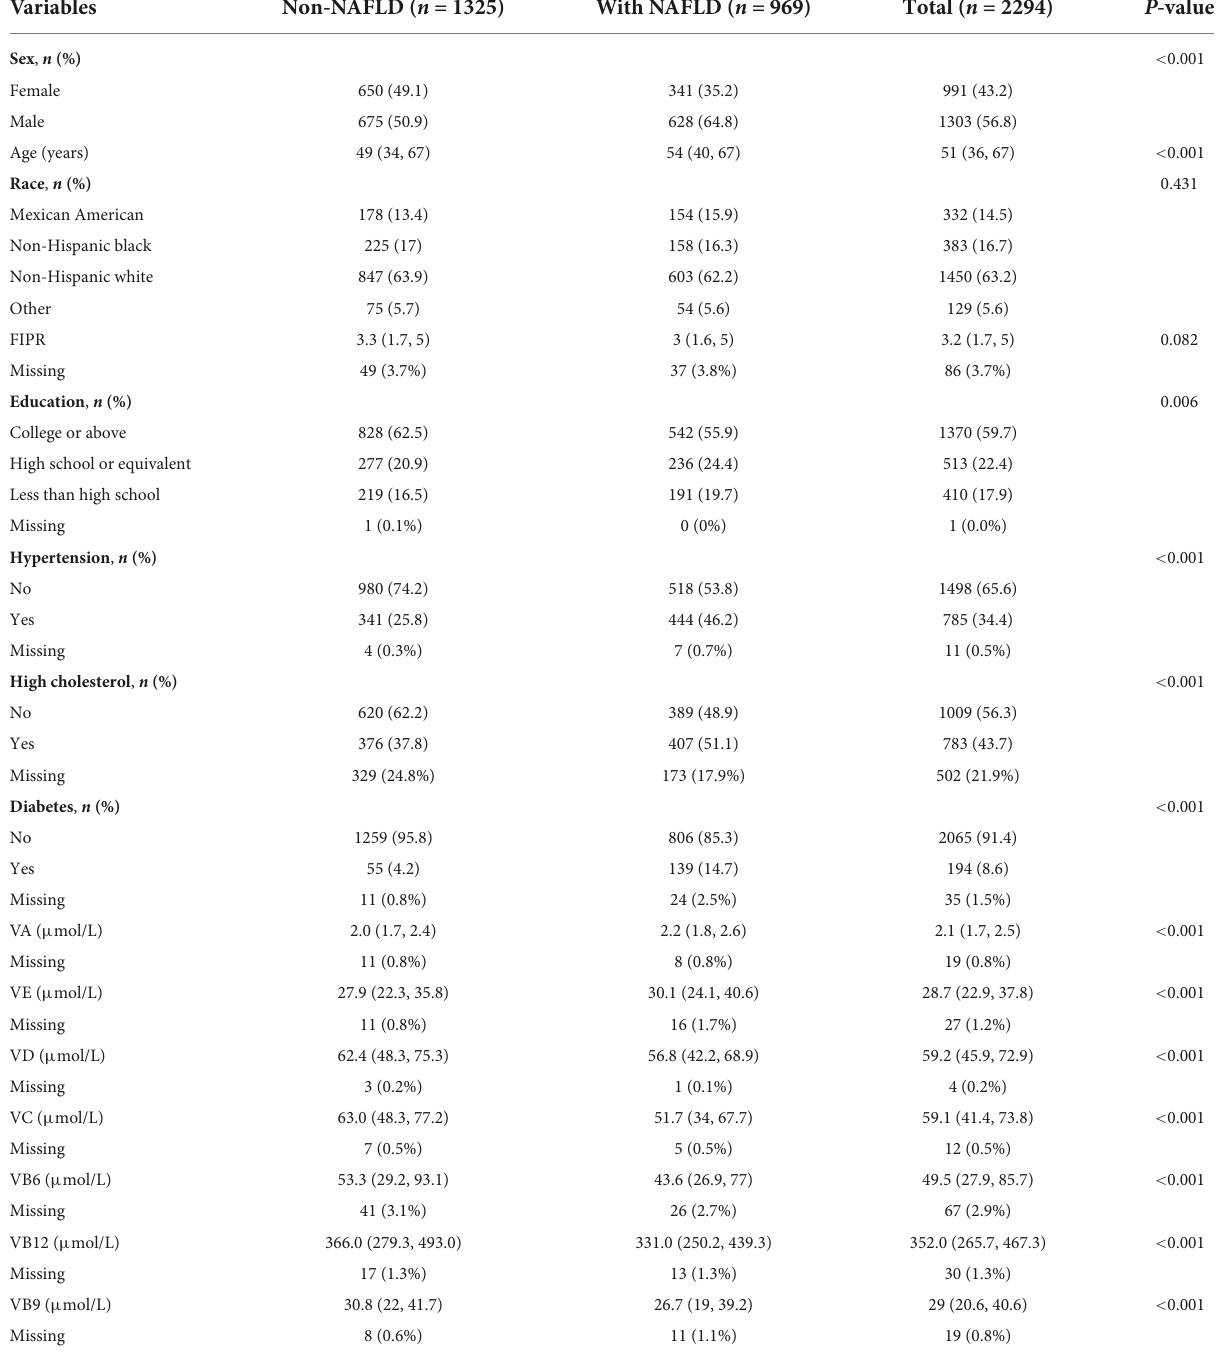
TABLE 1 Basic characteristics of participants by non-alcoholic fatty liver disease (NAFLD) in NHANES 2003–2006. Variables